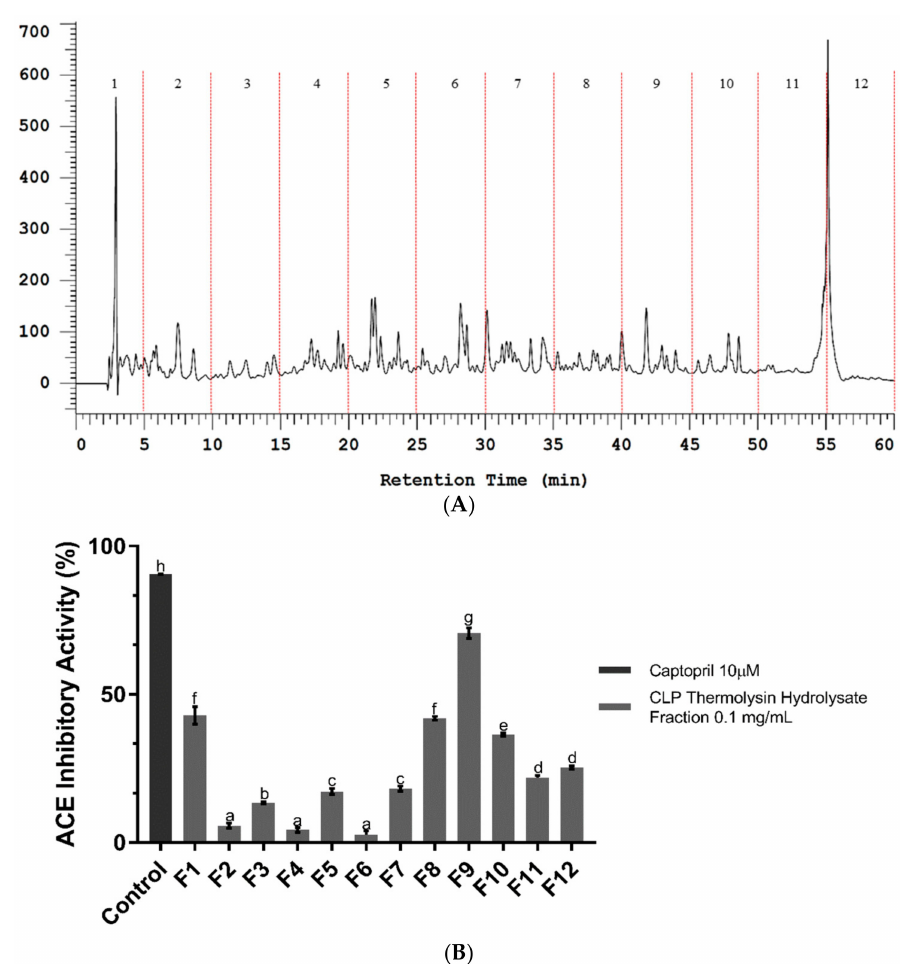
Figure 2. Bioassay-guided fractionation. ( A ) Reversed-phase high performance liquid chromatography (RP-HPLC) chromatogram of Caulerpa lentillifera protein (CLP) hydrolysate hydrolyzed by thermolysin. It is divided into 12 fractions; ( B ) ACE inhibitory activities of 12 RP-HPLC fractions. Each point is the mean of the three determinations ( n = 3) ± SD. Different letters labeled on the bar indicate significant difference ( p < 0.05). The concentration for each fraction is 0.1 mg/mL, and captopril (10 µ M) is used as positive